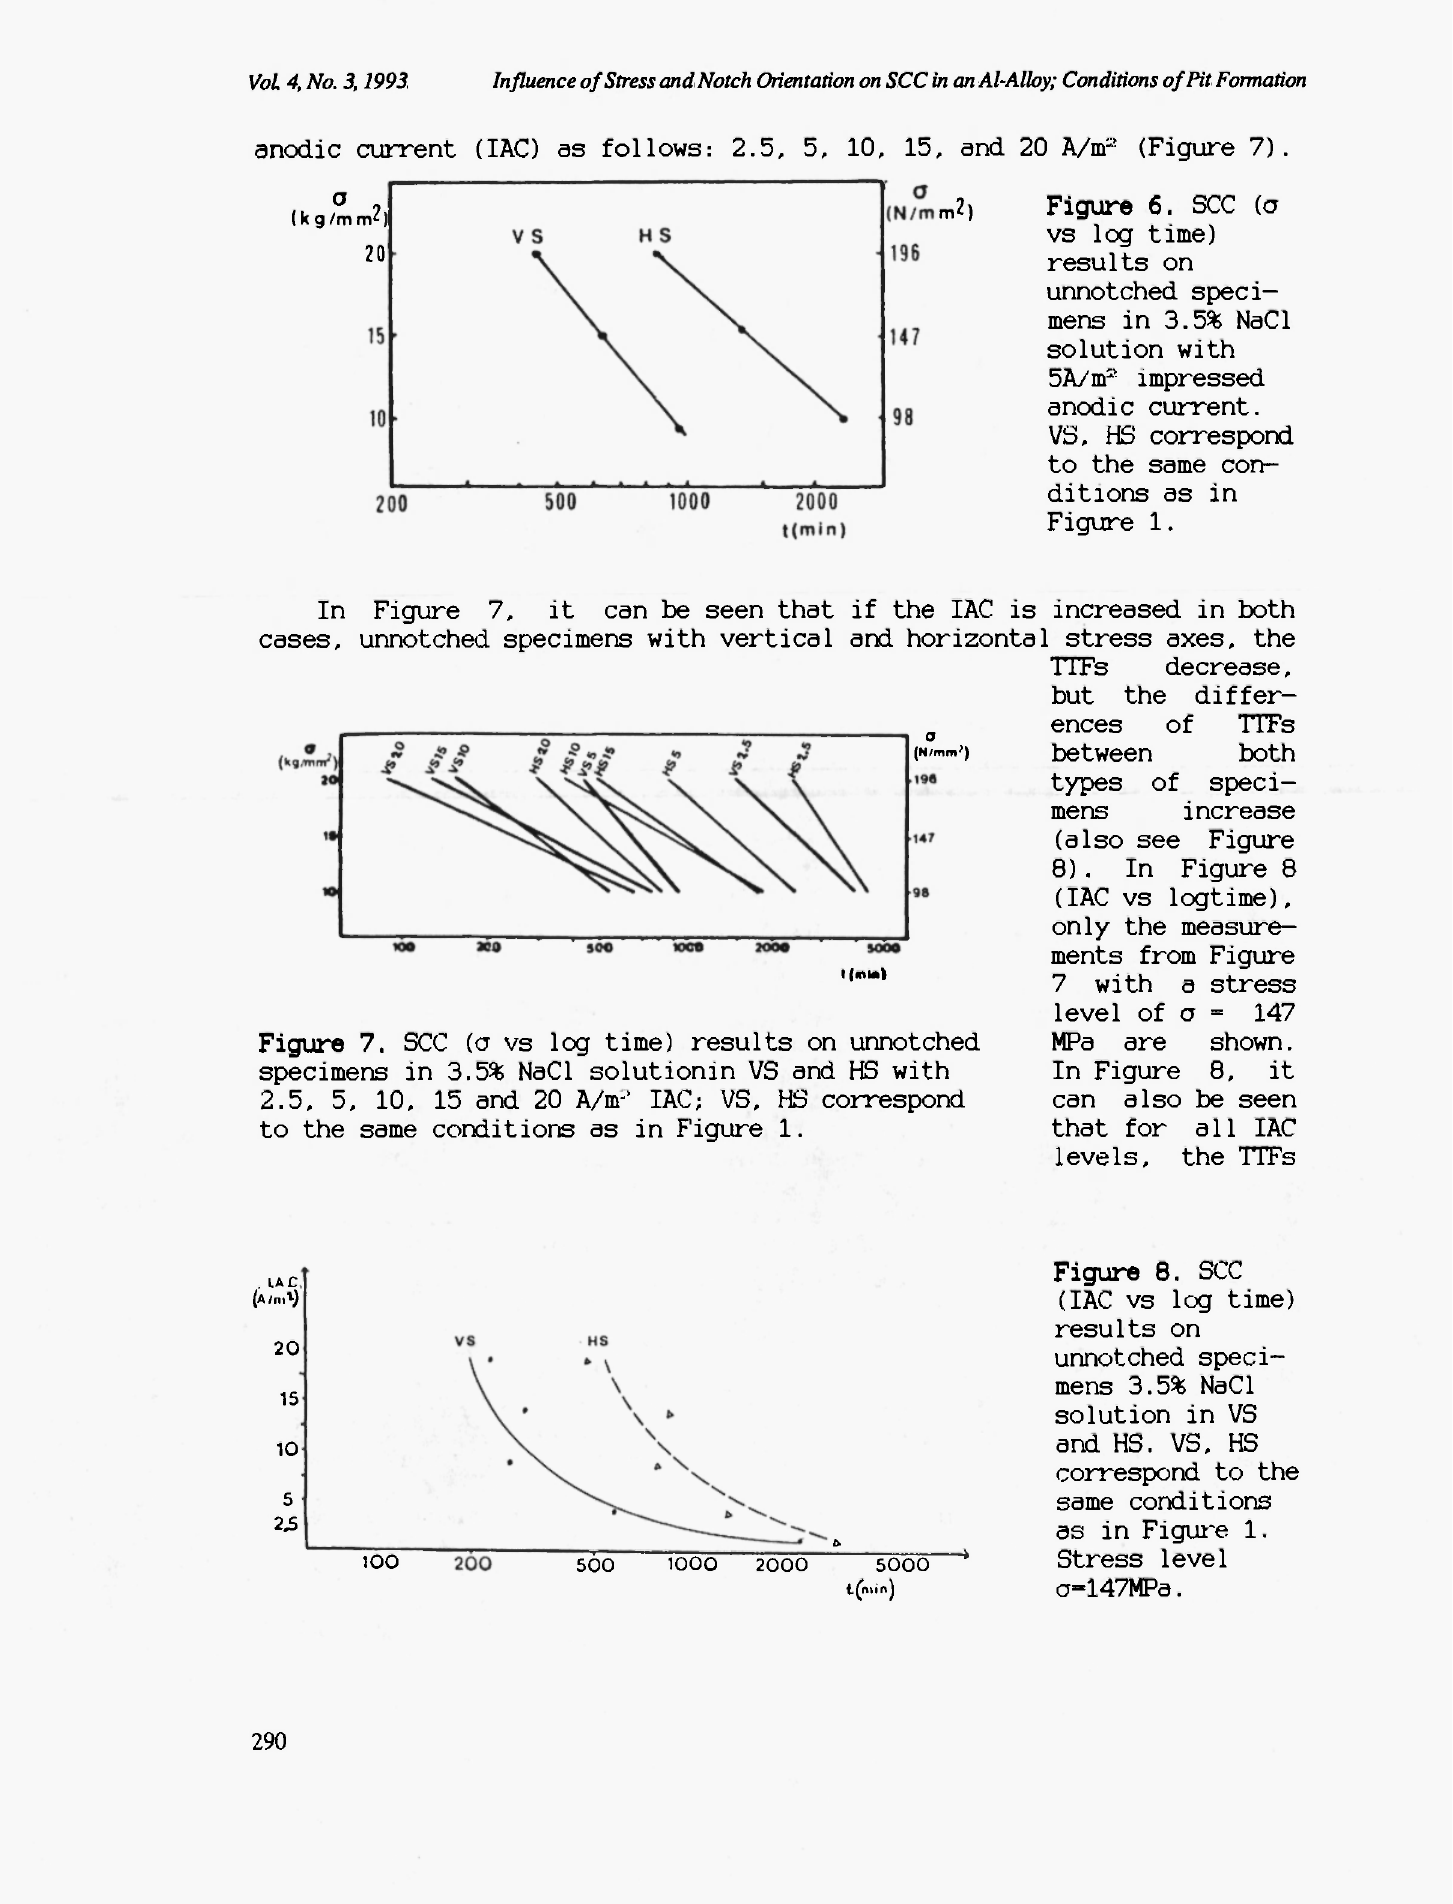
Figure 8. SCC (IAC vs log time) results on unnotched speci- mens 3.5% NaCl solution in VS and HS. VS, HS correspond to the same conditions as in Figure 1. Stress level